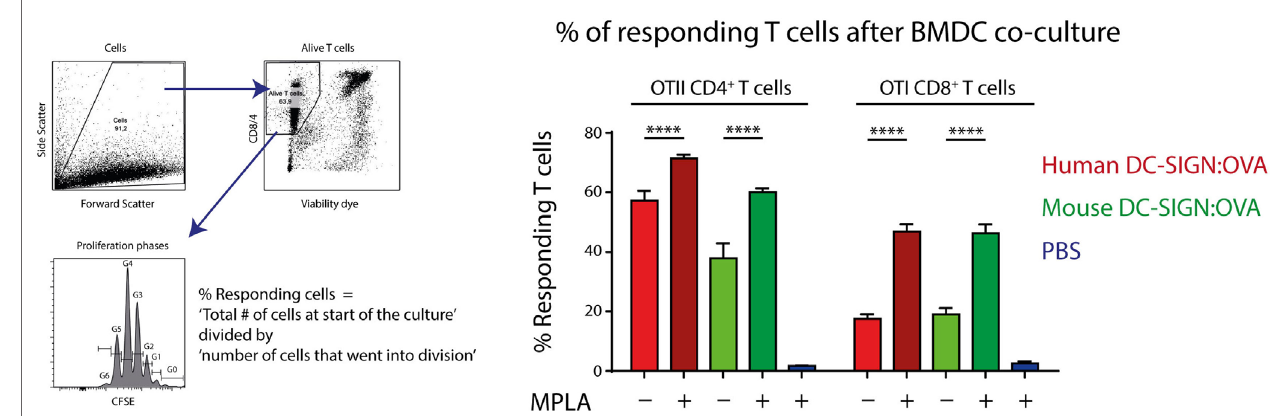
FigUre 3 | Antigen targeting to mouse- and human DC-SIGN (hDC-SIGN) on bone marrow-derived dendritic cells (BMDCs) leads to internalization, processing, and presentation to antigen-specific CD8 + and CD4 + T cells. GM-CSF cultured hDC-SIGN BMDCs pulsed with 1 μ g/ml α -mDC-SIGN:OVA or α -hDC-SIGN:OVA (1 h 37°C, with Fc block) presents processed antigen to CFSE-labeled OTI CD8 + or OTII CD4 + T cells after 3 days of co-culture. Also, the TLR4 ligand, monophosphoryl lipid A (MPLA) consistently boosts antigen presentation. T cell proliferation is represented as percentage responding cells (“calculated cells at the start of culture”/“number of cells that went into division” × 100). Data represented as mean ± SEM, co-cultured in triplicates (analysis of variance with Tukey post hoc **** P < 0.0001), representative of three individual